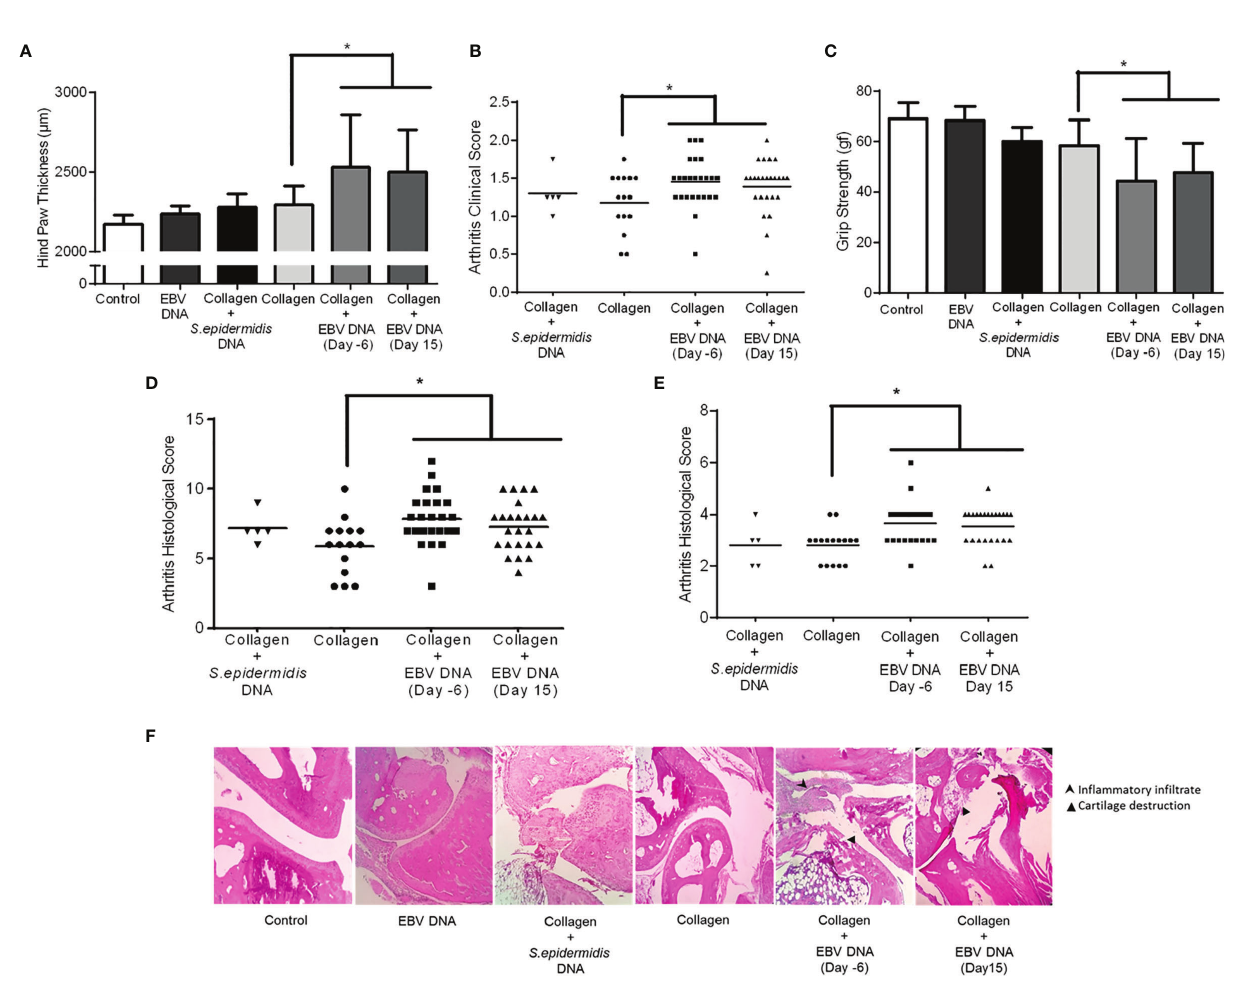
FIGURE 3 | Effect of EBV DNA on the severity of arthritis in the collagen-induced arthritis mouse model. (A) Average hind paw thickness in C57BL/6J mice treated with distilled water, EBV DNA only, type II chicken collagen, S. epidermidis DNA 6 days prior to collagen, EBV DNA 6 days before collagen or EBV DNA 15 days after collagen. (B) Clinical scores of arthritic mice treated with S. epidermidis DNA 6 days prior to collagen, EBV DNA 6 days before collagen or EBV DNA 15 days after collagen, compared to mice treated with collagen only. (C) Average grip strength of arthritic animals compared to control mice treated with distilled water. (D) Histological scores of sections obtained from ankles of arthritic animals treated with S. epidermidis DNA 6 days prior to collagen, EBV DNA 6 days before collagen or EBV DNA 15 days after collagen compared to mice treated with collagen only. (E) Histological scores of sections obtained from footpads of arthritic animals treated with S. epidermidis DNA 6 days prior to collagen, EBV DNA 6 days before collagen or EBV DNA 15 days after collagen compared to mice treated with collagen only. (F) Representative histological sections of ankle joints from mouse groups. * indicates